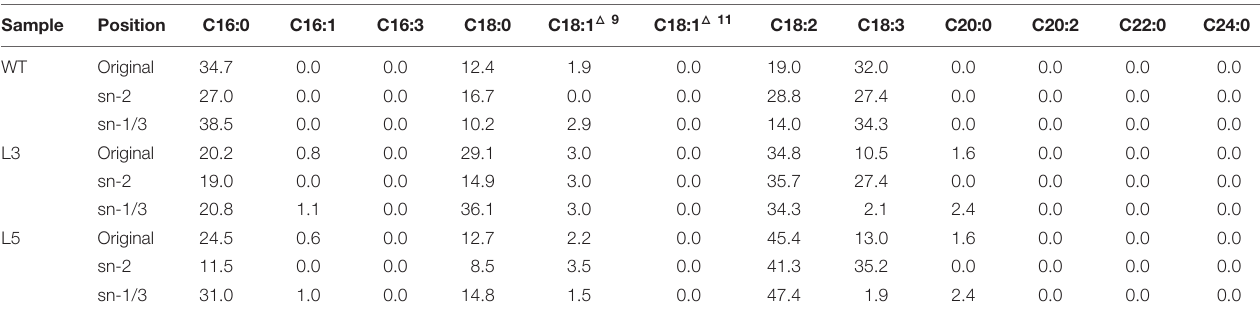
FIGURE 6 | TEM imaging of the intracellular structures in potato leaves in the three developmental stages. Lipid droplet (LD), plastoglobuli (PG), chloroplast (C), starch granule (SG), and mitochondria (M) can be clearly visualized. The arrowheads point at PG. (A–C) Sections of leaf cells in WT, L3, and L5, respectively at the flowering stage; (D–F) Sections of leaf cells in WT, L3, and L5, respectively at the mature stage; (G–I) Sections of leaf cells in WT, L3, and L5, respectively at the senescent stage. PGs were observed in the chloroplast and LDs in the cytosol. L3 and L5 seem to display enlarged size but irregular morphology of LDs compared to WT, while PGs showed a similar trend of enlargement with LDs in plant development in both WT and the two transgenic lines. The scale bars correspond to 1 µ m. TABLE 1 | Positional distribution of fatty acids in TAG of potato senescent